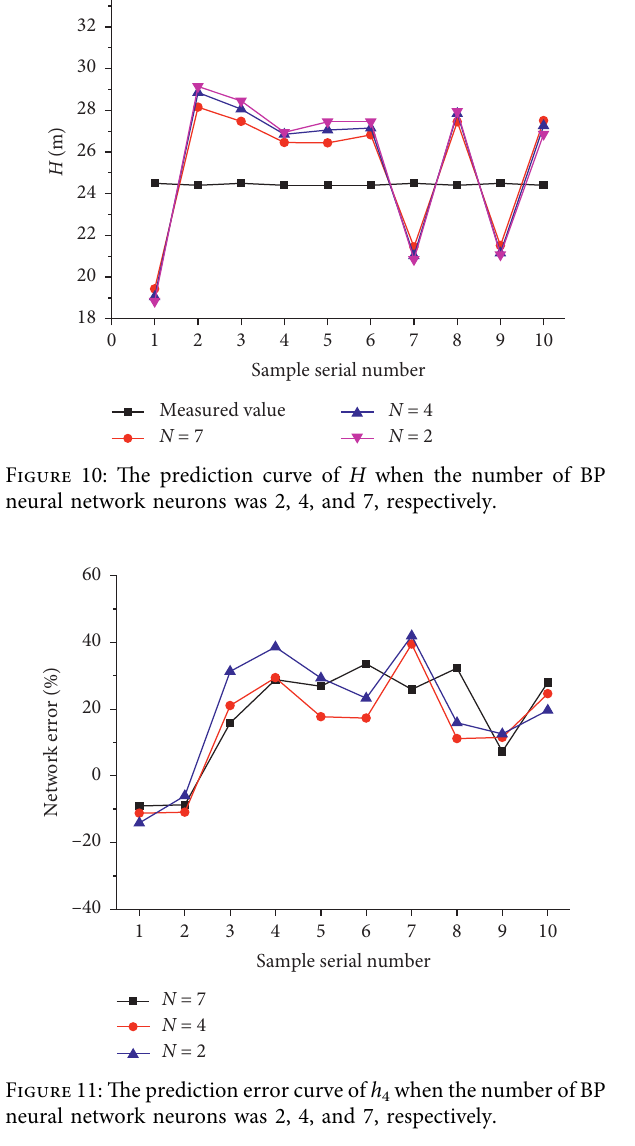
4 by using different